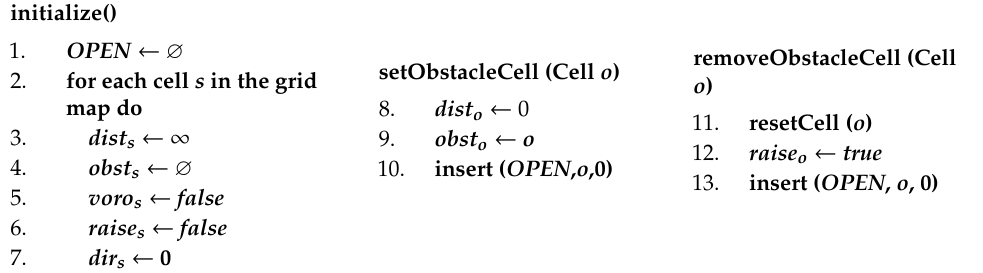
Table 1. The pseudocode for initialization.